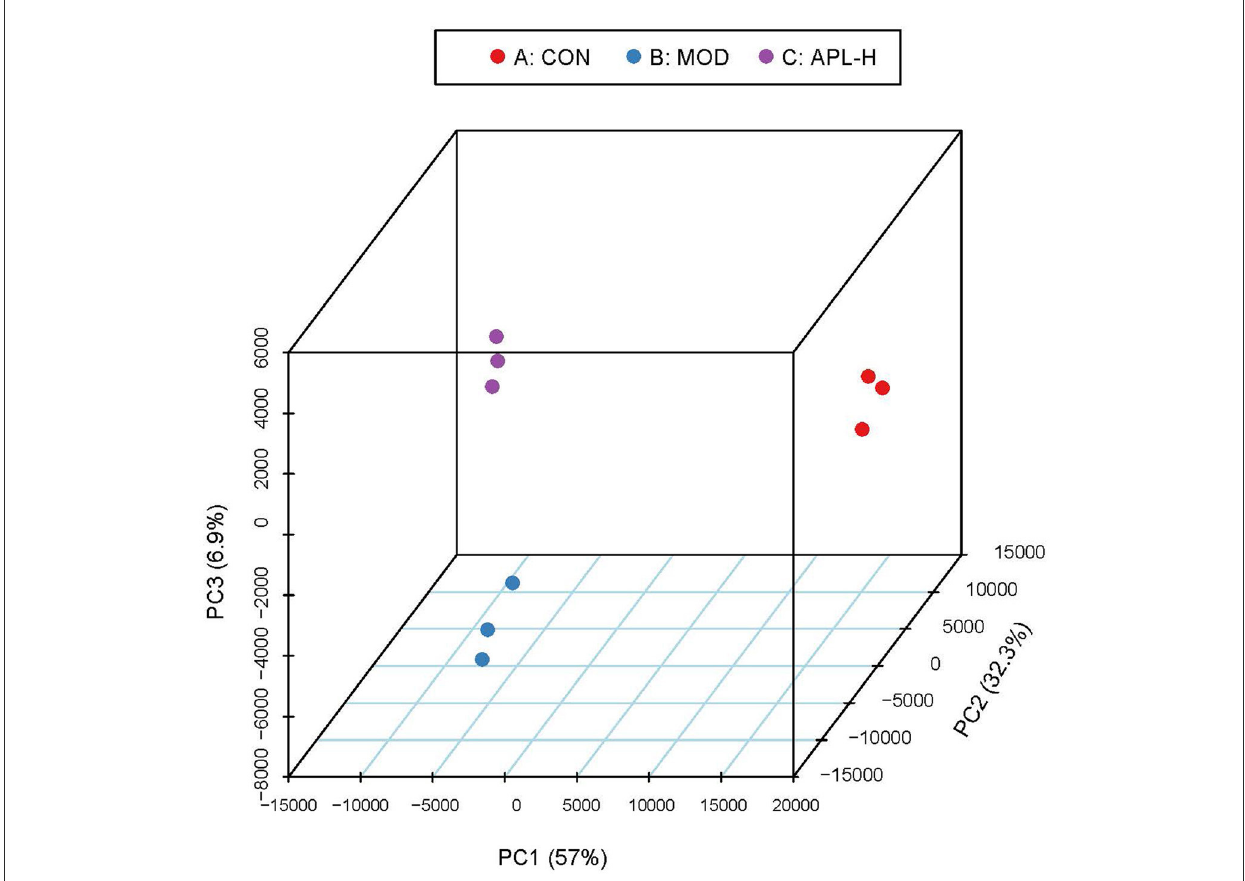
FIGURE5 PCA score scatter plots of identified proteins.